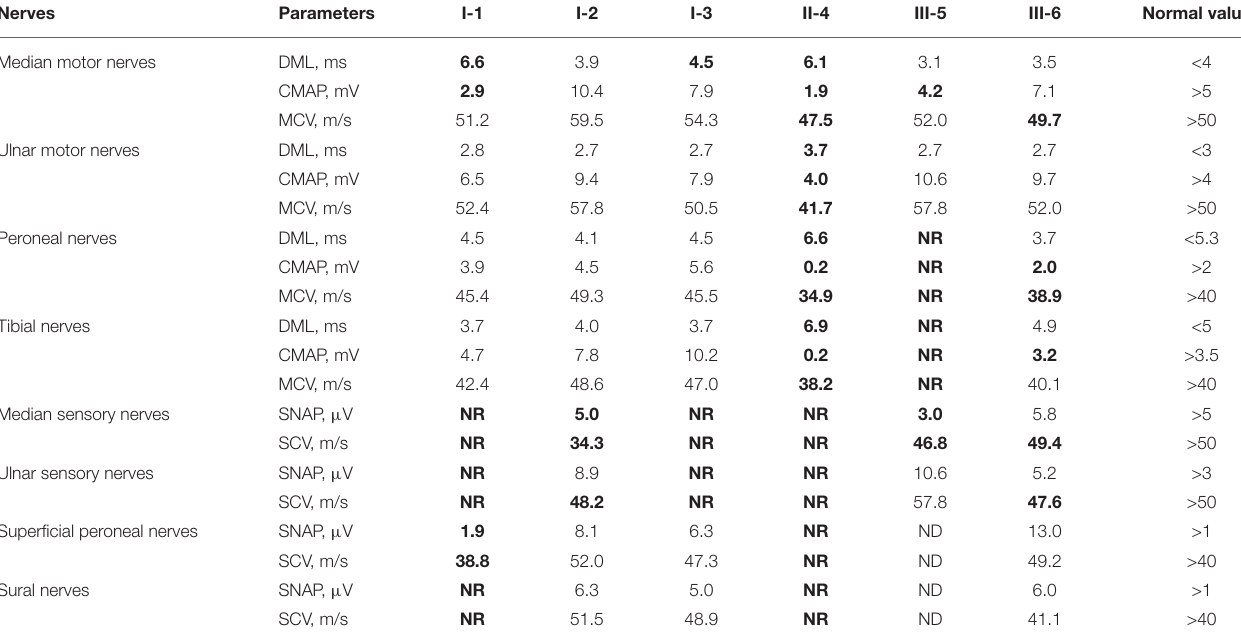
TABLE 3 | Neuroelectrophysiological features of patients with symptomatic ATTR having the Gly83Arg variant. Nerves Parameters Normal values Median motor